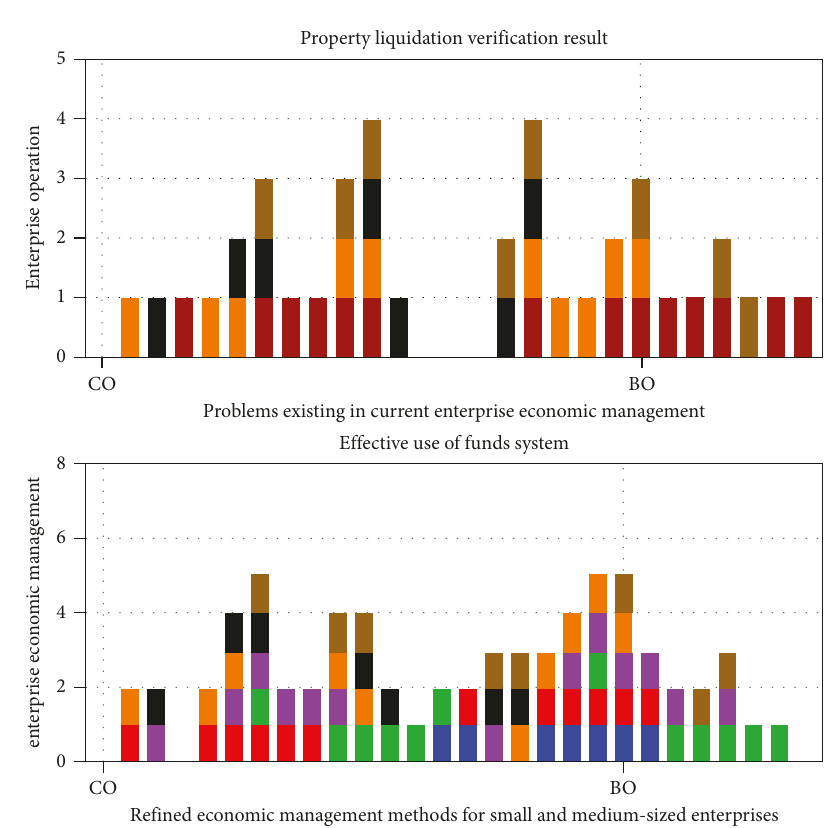
Figure 11: Refined economic management results for small- and medium-sized enterprises.